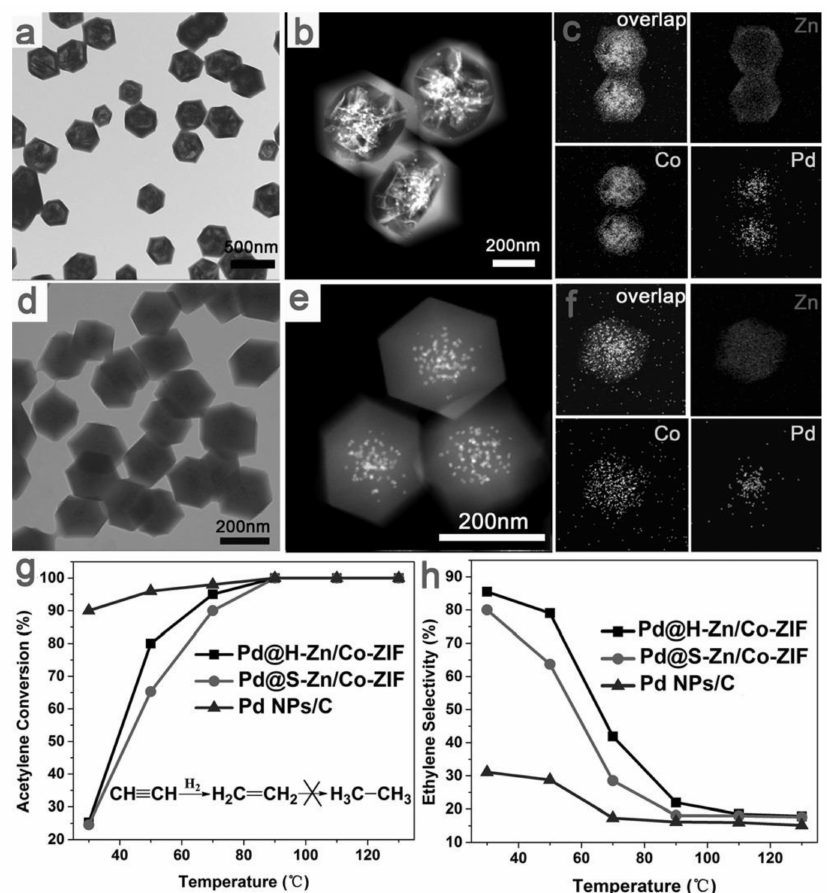
Figure 16. TEM pattern ( a ), HAADF-STEM image ( b ), and EDX mapping ( c ) of Pd@H-Zn/Co-ZIF. TEM pattern ( d ), HAADF-STEM image ( e ), and EDX mapping ( f ) of Pd@S-Zn/Co-ZIF. Acetylene conversion ( g ) and ethylene selectivity ( h ) as functions of temperature (reproduced with permission from [276]. Copyright 2015 WILEY-VCH Verlag GmbH & Co.